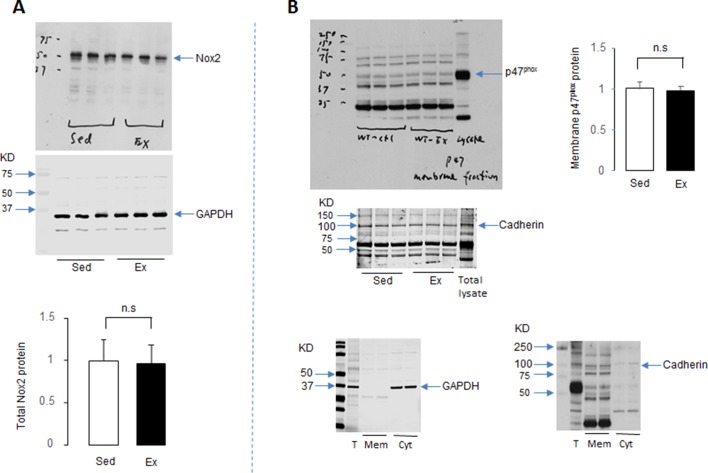
Myocardial Nox2 is unchanged during acute exercise.Protein levels of total Nox2 (A) and p47phox in membrane fraction (B) in normal mouse hearts after acute exercise (Ex). GAPDH and cadherin were used as cytosolic and membrane protein marker respectively. Sed: sedentary control, T: total heart tissue lysate, Mem: membrane fraction, Cyt: cytosolic protein. n.s: no significance. n = 3/group.